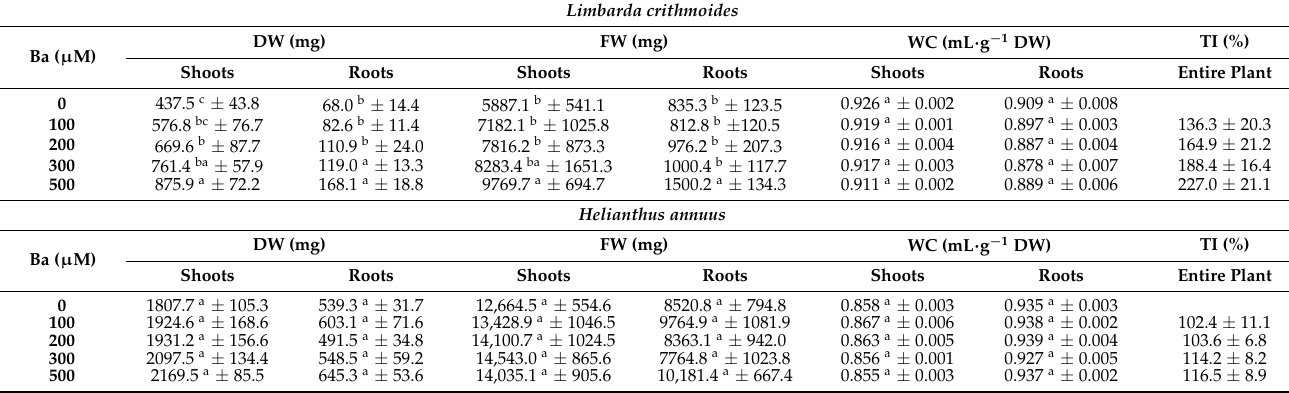
Table 1. Assessment of the growth (DW: dry weight, FW: fresh weight, WC: water content) and the metal tolerance index (TI %) in the shoots and roots of Limbarda crithmoides and Helianthus annuus after 45 days of Ba exposure. Data are shown as means ± SD; values with lowercase denote significant differences at p <